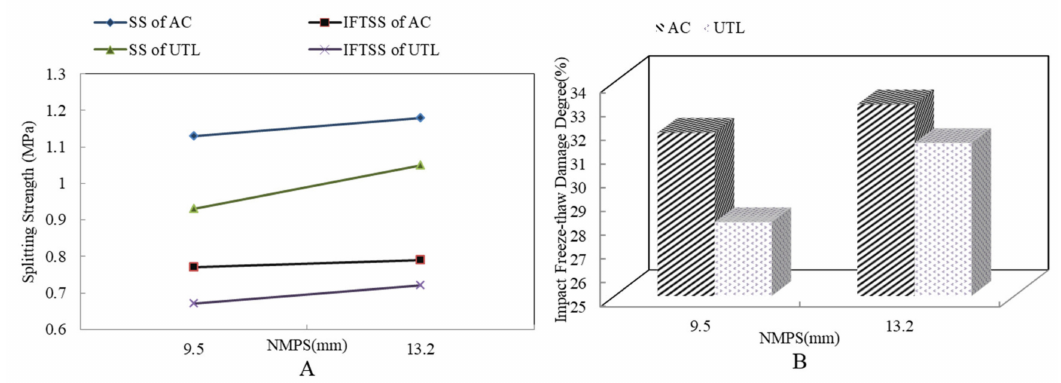
Figure 5. Results of impact freeze-thaw spilt test with di ff erent NMAS: ( A ) SS and IFTSS; ( B ) IFTDD.